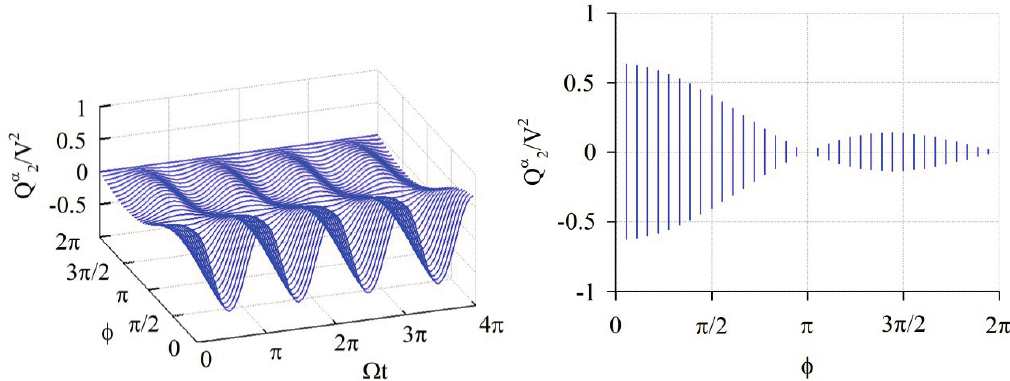
Figure 6. The numerical results of a feature element of generalized force vector ( 2 The graph at the right-hand side are the projections of the graphs at the left-hand side on the plane containing ϕ -axis and Q